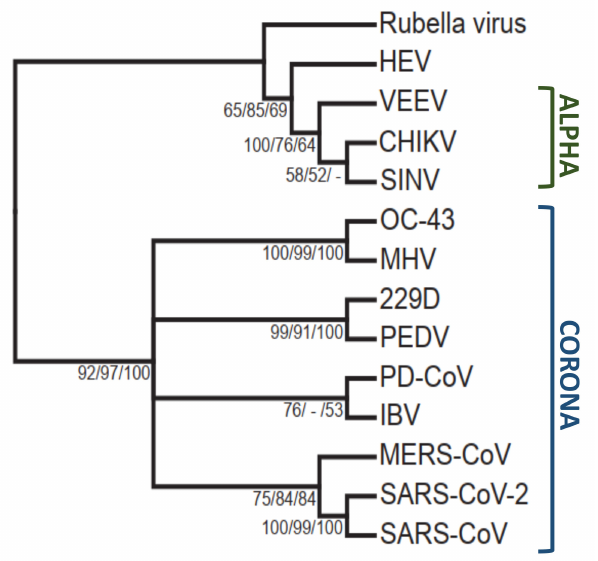
Figure 3. Phylogenetic tree of the viral macrodomains proteins sequences constructed with the neighbor joining method using Geneious Bioinformatics